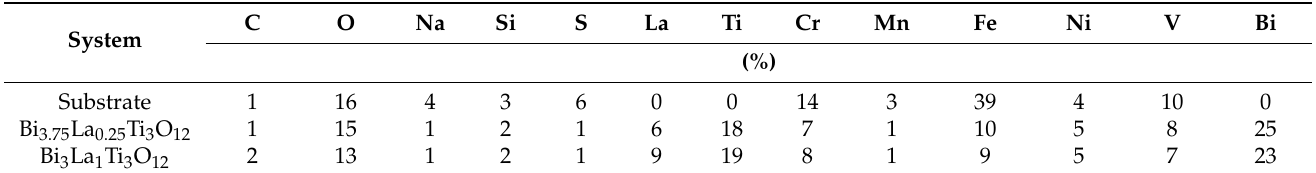
Table 6. Chemical analysis for Bi 3.75 La 0.25 Ti 3 O 12 and Bi 3 La 1 Ti 3 O 12 coatings and the substrate at a temperature of 700 ◦ C.